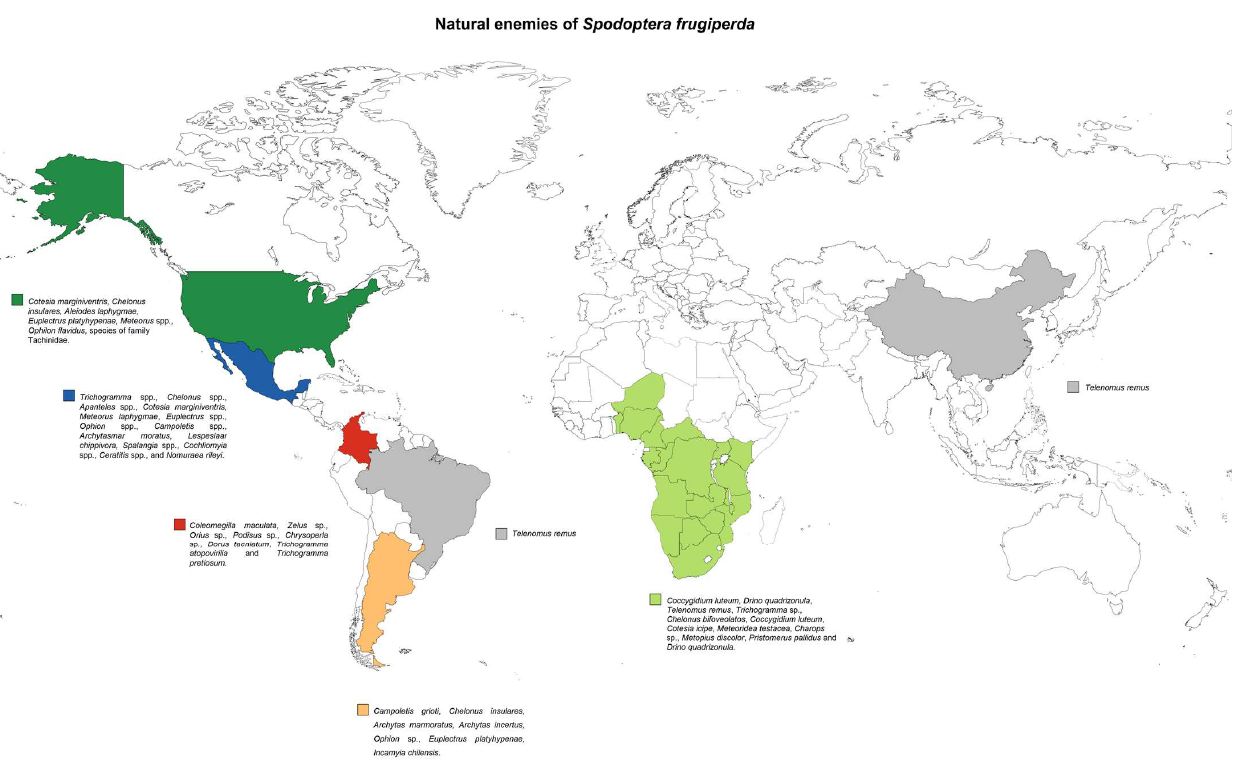
Figure 15. Geographical distribution of the leading natural enemies reported or used in the control of S. frugiperda world- wide.